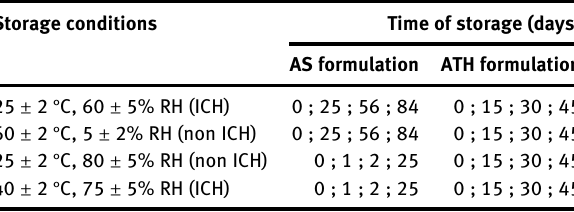
Table  : Experimental design of the ASAP study for AS and ATH formulations. Storage in ICH and non ICH conditions and time of storage.